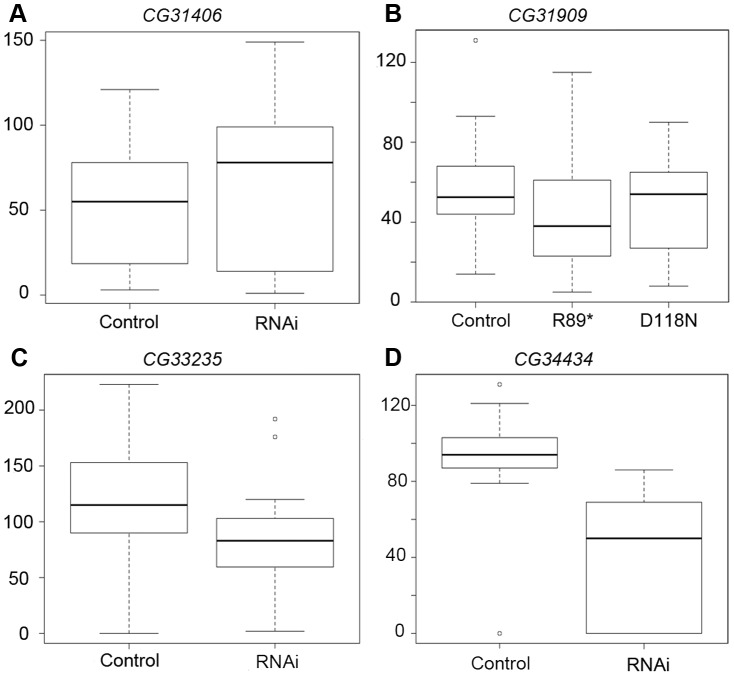
RNAi of CG34434 leads to a reduction in male fecundity.We measured fecundity in male flies by mating F1 RNAi, mutant or control males to 1–2 females overnight, and then counting the number of offspring produced per female over a 10-day period. For CG31406 (A), CG33235 (C), and CG34434 (D) we compared fecundity between the control (curly) and RNAi (straight winged) F1 males produced by crossing the “GD” UAS-RNAi stocks to an Actin-Gal4 driver (see methods). As CG31909-RNAi did not produce knockdown of the target gene (Figure S1), we generated a series of Fly-TILL mutants for this line, and crossed a premature termination codon mutant (R89*) and a nonsynonymous mutant (D118N) to a deficiency covering the gene (w1118; Df(2L)BSC291/CyO). We crossed w1118 to the same deficiency as a control, then compared the Fly-TILL mutants to the w1118 control using the same single day mating assay (B). Only CG34434-RNAi males (D) showed a significant decrease in fecundity compared to their control siblings (p<0.0001). For CG31909, CG33235, and CG34434, the data shown are the results of the first day of a 5-day long sperm exhaustion assay whereas for CG31406 only the 1-day single fly matings trials were attempted.